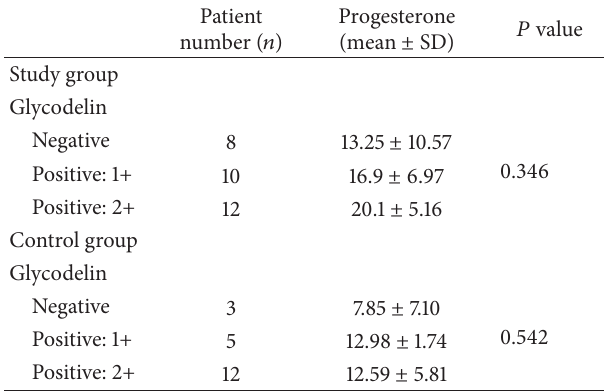
Table 3: Glycodelin expression and progesterone values of